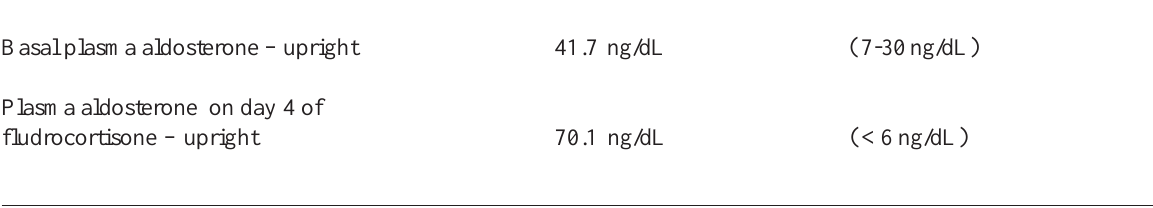
Table 1. Fludrocortisone suppression test